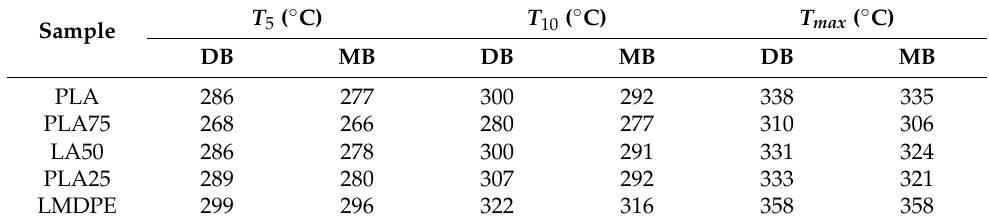
Figure 6. TGA (thermogravimetric analysis) curves for ( a ) neat polymers, ( c ) polymer blends and the derivative (DTG) curves for ( b ) neat polymers, ( d ) polymer blends prepared by dry (DB) and melt blending (MB). Table 5. TGA data of neat polymers and PLA/LMDPE